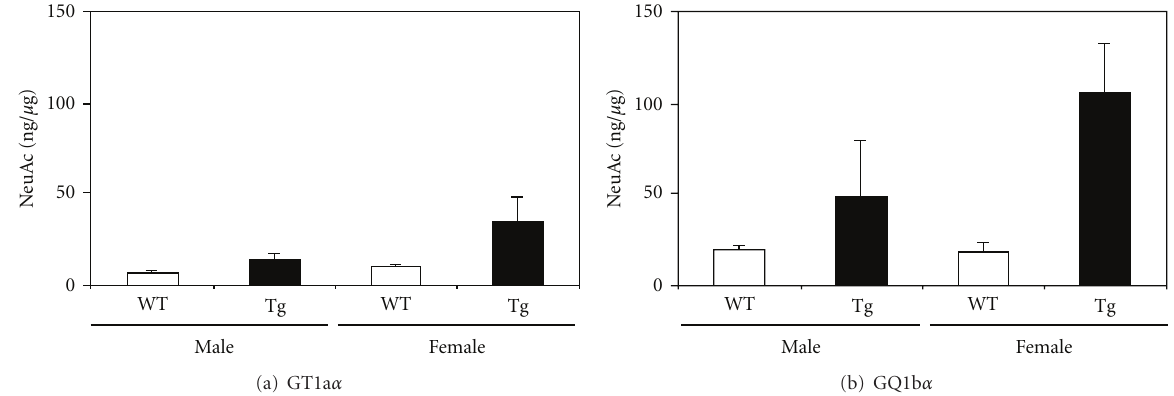
Figure 2: The content of Chol-1 α antigens, GT1a α (a) and GQ1b α (b), in AD model mouse brains [85]. GT1a α and GQ1b α extracted from brains of AD model double transgenic mice coexpressing mouse/human chimeric APP with the Swedish mutation and human presenilin-1 with a deletion of exon 9 (Tg) or age-matched wild-type mice (WT) were quantified by densitometric analysis of high-performance thin- layer chromatography immunostaining. n = 3–7. (Reproduced from [85] with permission).